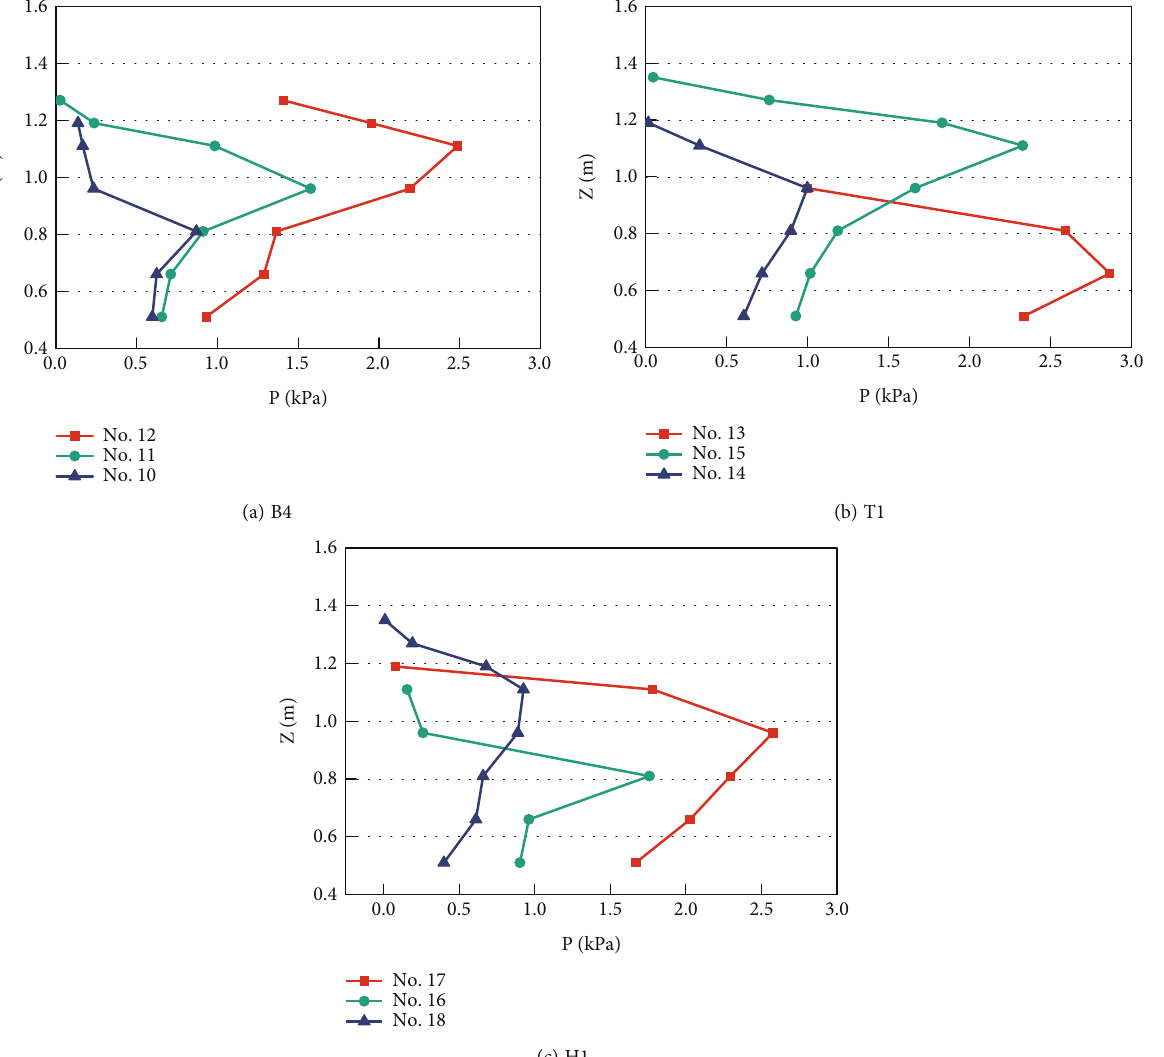
Figure 11: Impact pressure distributions from the impulse waves of landslide bodies B4, T1, and H1 on the opposite bank (Nos. 10 –